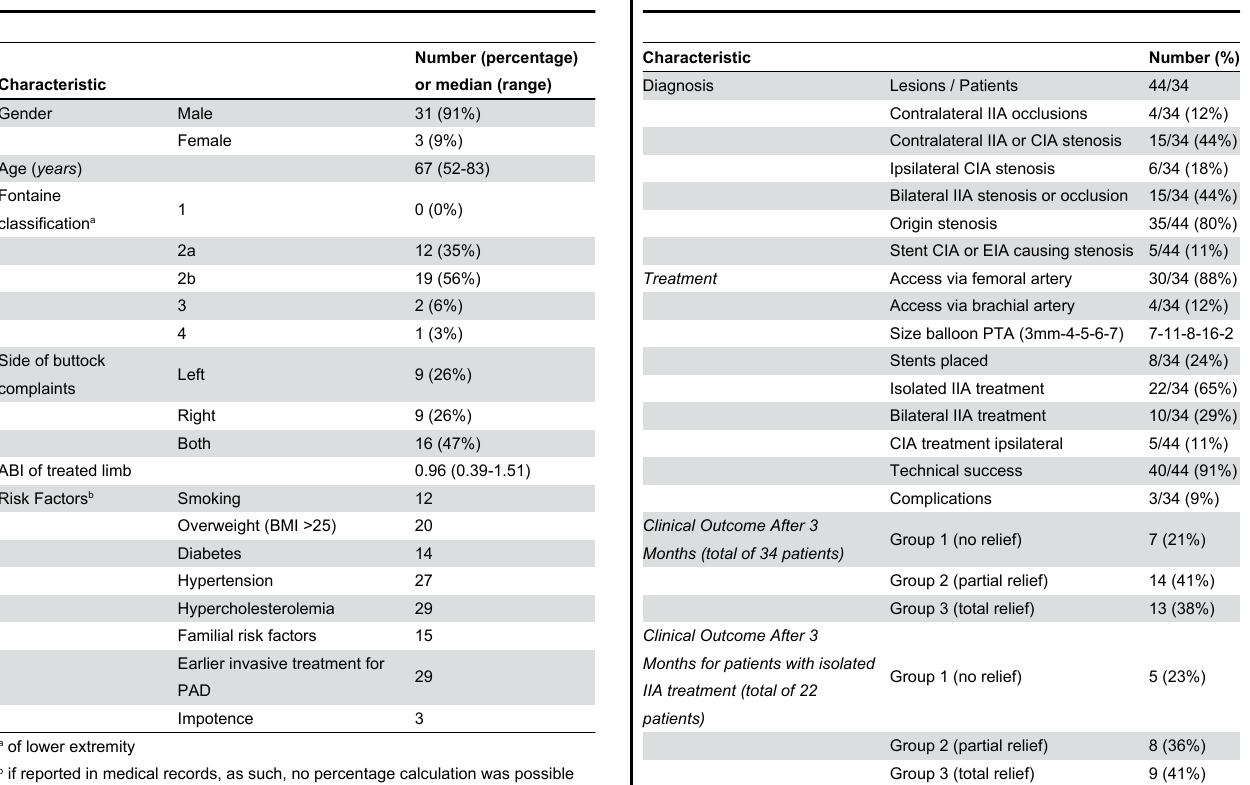
Table 1. Baseline characteristics. Table 2. Diagnosis, treatment and clinical